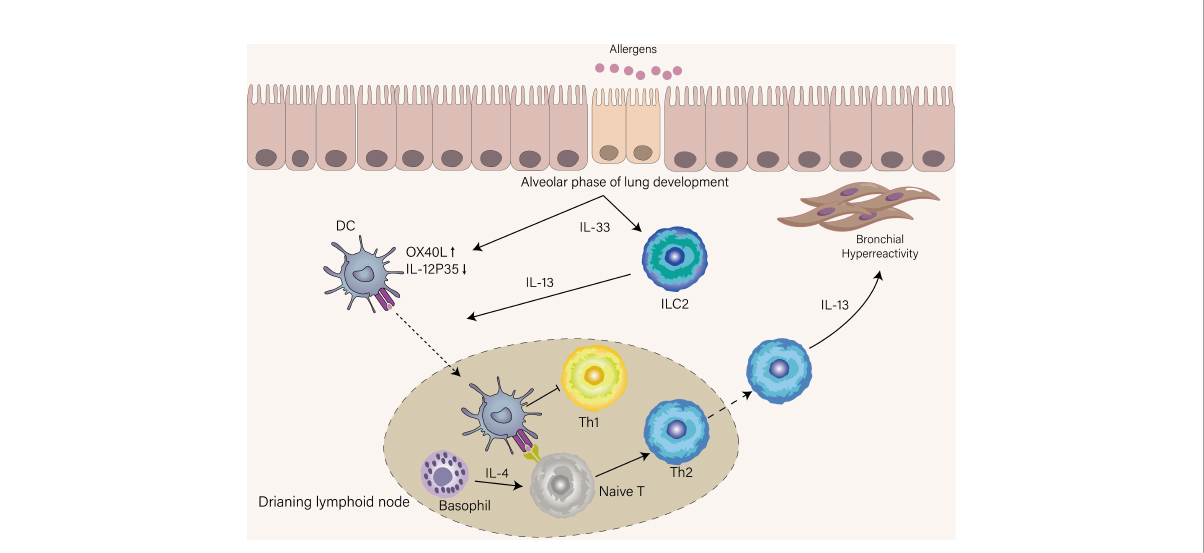
FIGURE 2 Mechanisms that condition inception of early-life asthma. IL-33 was spontaneously produced by epithelial cells until the age of three years, a period termed the alveolar phase of lung development. Under the in fl uence of IL-33, DCs upregulate OX-40L and suppress IL-12p35, thus favoring Th2 cell skewing, and ILC2s were accumulated and activated in the lung. ILC2s provide IL-13 to boost DCs that recognize allergens to migrate into lymphoid tissue. DCs in lymphoid tissue promote Th2 differentiation with the help of IL-4 derived from basophils and simultaneously inhibit Th1 differentiation. IL-13 derived from Th2 induces AHR, which is a hallmark of recurrent wheeze in children who develop